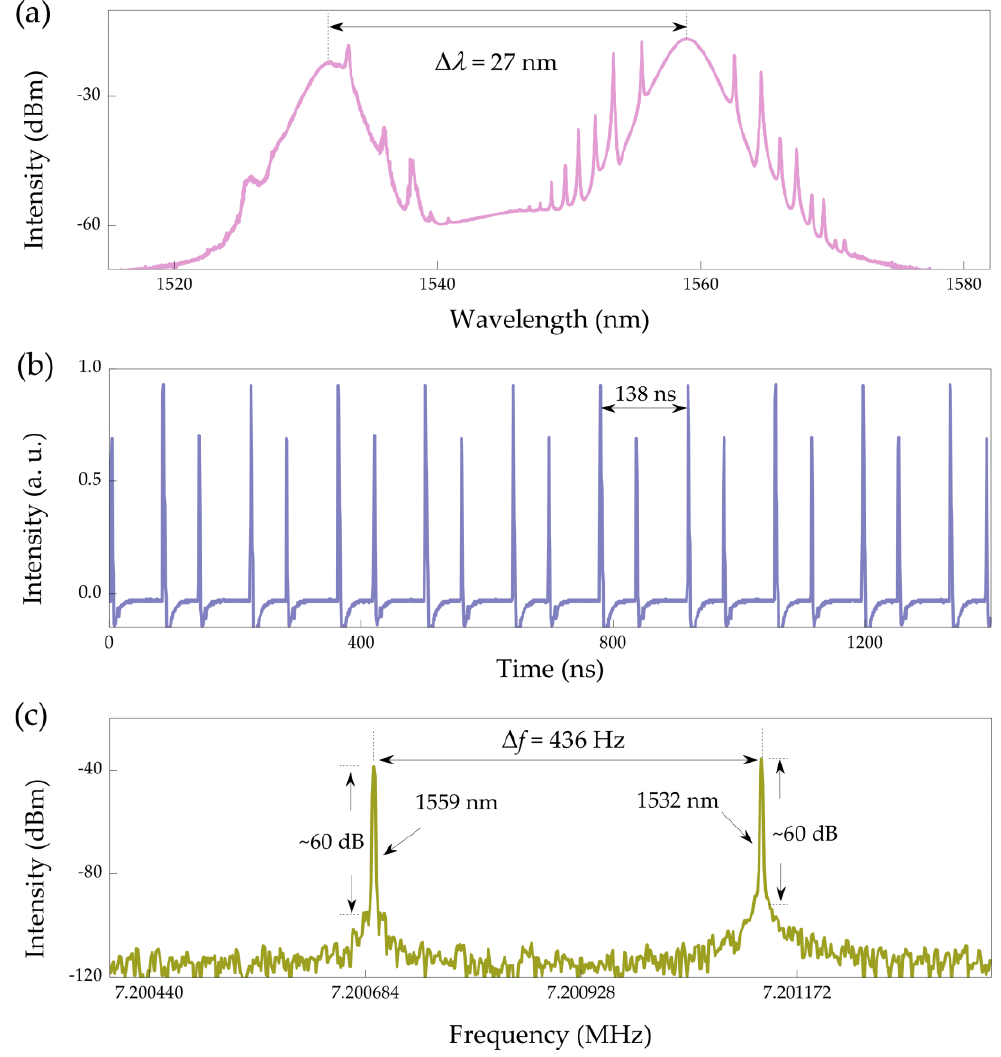
Figure 4. Dual-wavelength conventional solitons. ( a ) Optical spectrum at 1532 and 1559 nm, ( b ) pulse train, and ( c ) corresponding fundamental radio-frequency spectrum.